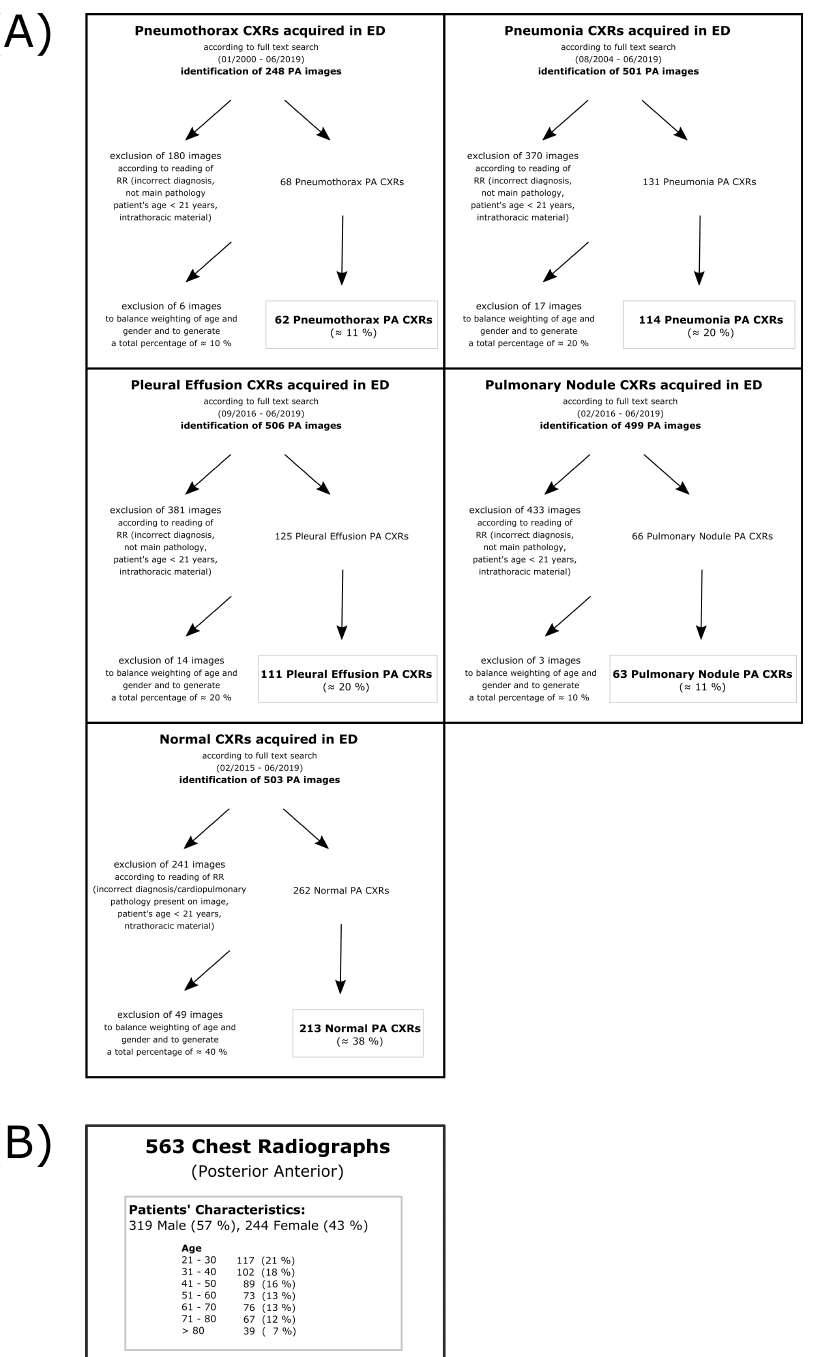
Figure 1. Preselection of study cohort—( A ) Flow charts that display the preselection process of each subcohort (normal, pneumothorax, pneumonia, pleural effusion and pulmonary nodule). Images were identified by full text search in the local PACS. All images were preread by a radiology resident not participating in the main reading process. Images that did not meet inclusion criteria (correct diagnosis, main pathology, patient’s age ≥ 21, no foreign material) were excluded. After a first preselection, further random images were excluded to balance out quantities in terms of age and gender in the different cohorts; ( B ) shows the overall patient’s characteristics in the final cohort. Notice that the preselection was based on the main pathology which means that also more than one pathology was possible (e.g., pleural effusion + basal consolidation or pneumothorax + pleural effusion). Frequencies could therefore also differ from board-certified radiologists’ evaluation (see Figure